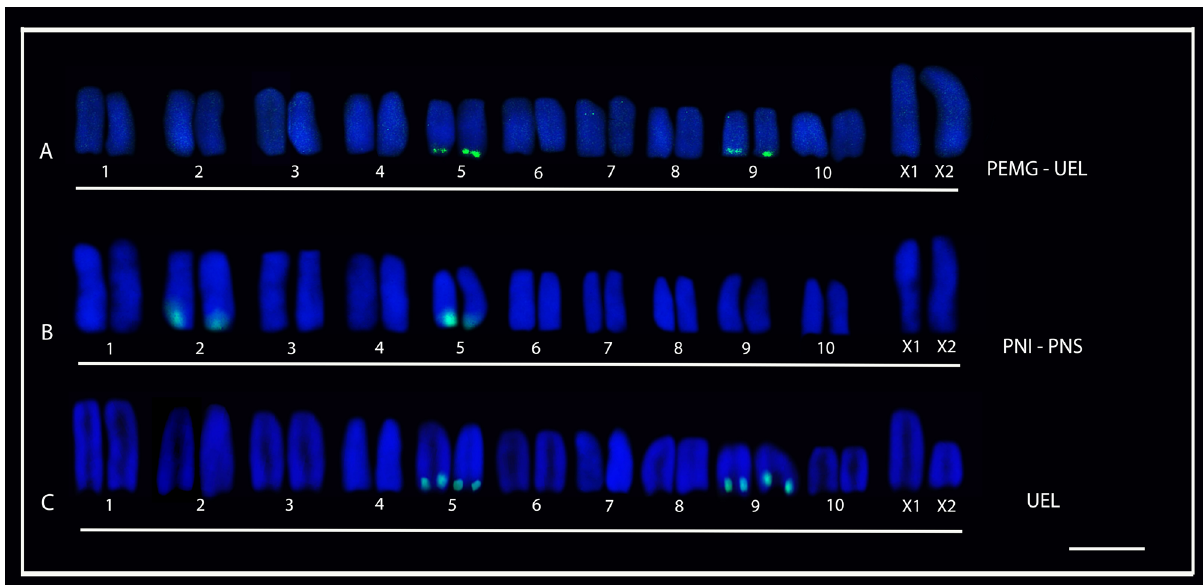
Figure 4 – Karyotypes of males of two Lycosa species submitted to fluorescent in situ hybridization (FISH) with 18S rDNA probe. In ( A ) and (B) L. erythrognatha: in (A) from Mata dos Godoy State Park (PEMG) and State University of Londrina (UEL), showing the sites of 18S rDNA in pairs 5 and 9; in ( B ) from Iguaçu National Park (PNI) and Superagui National Park (PNS) showing ribosomal sites in pairs 2 and 5; in ( C ) L. sericovittata from UEL, with sites of 18S rDNA in pairs 5 and 9. Bar = 10